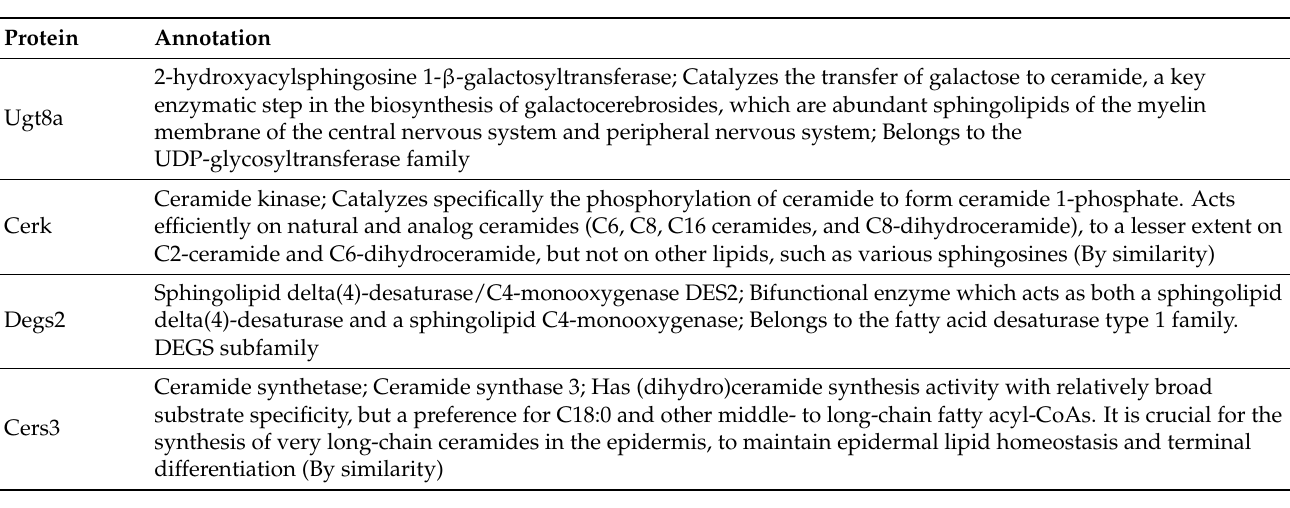
Table 8. Functional annotation of Ugt8a protein association